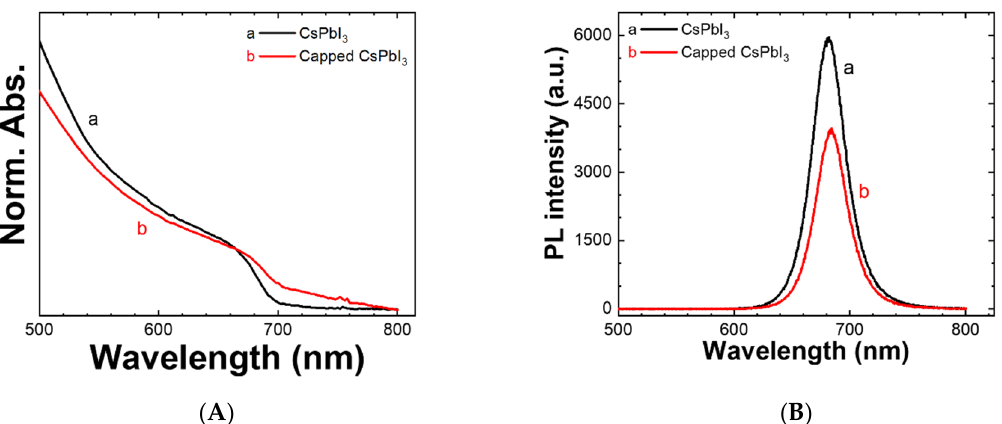
Figure 1. ( A ) Normalized UV-Vis. absorption spectra (normalized absorbance at band edge) of (a) pristine CsPbI 3 PQDs without the peapod capping and (b) PbSO 4 -oleate-capped CsPbI 3 PQDs. ( B ) Photoluminescence (PL) spectra of (a) pristine CsPbI 3 PQDs without the peapod capping and (b) PbSO 4 -oleate-capped CsPbI 3 PQDs. Photoluminescence quantum yields of the pristine CsPbI 3 PQDs and the capped CsPbI 3 PQDs are in ( B ). PbSO 4 -oleate capping reaction time was 60 min.